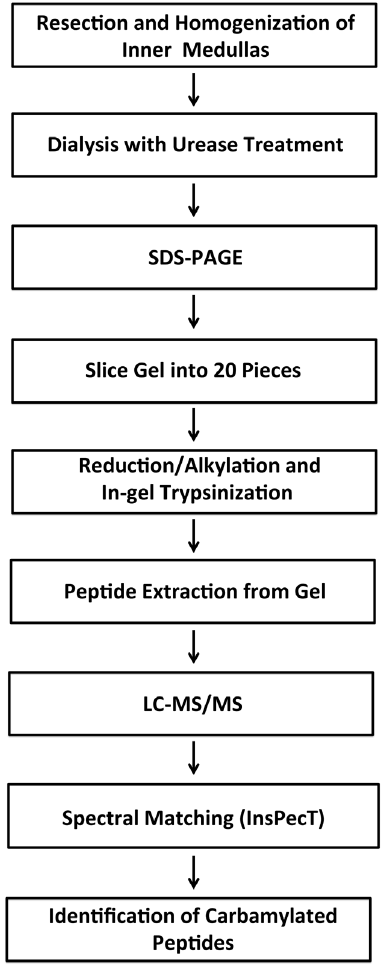
Figure 1. Workflow for mass spectrometry experiments.